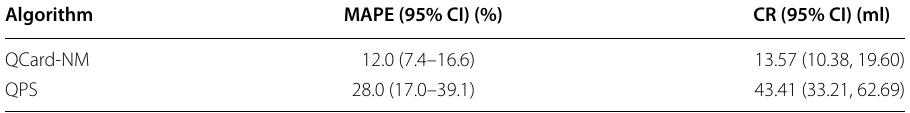
Table 2 The QCard-NM and QPS algorithms repeatability assessment in the supine/prone dataset; MAPE and CR were calculated for the QCard-NM and QPS algorithms between repeated scans Algorithm